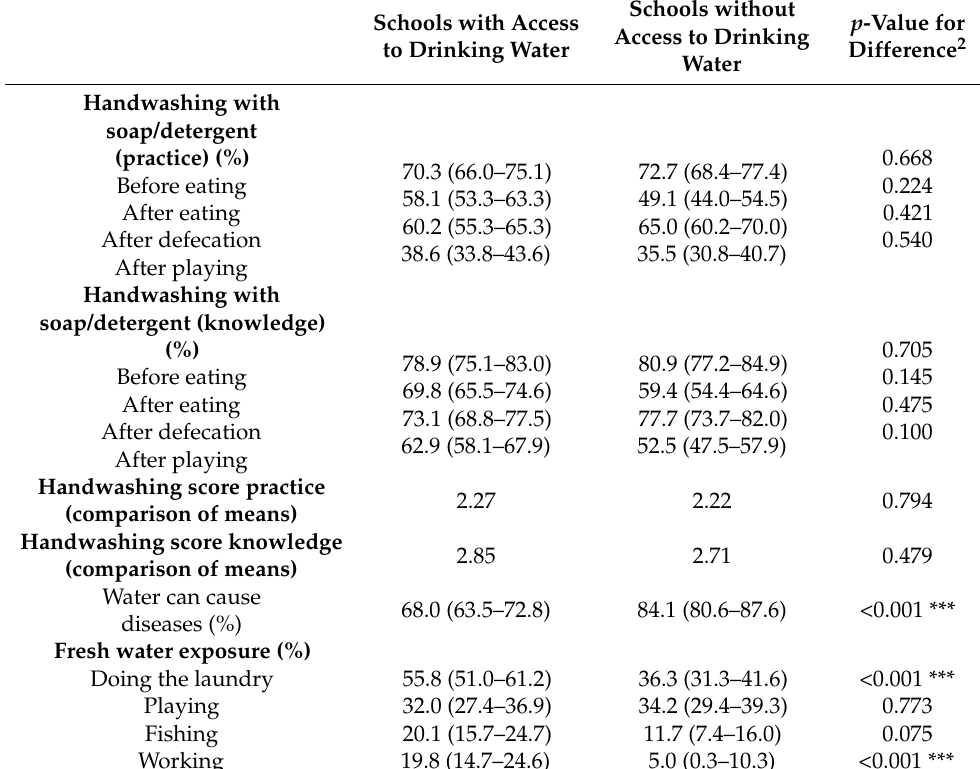
Table 3. Handwashing and water-related knowledge and practices 1